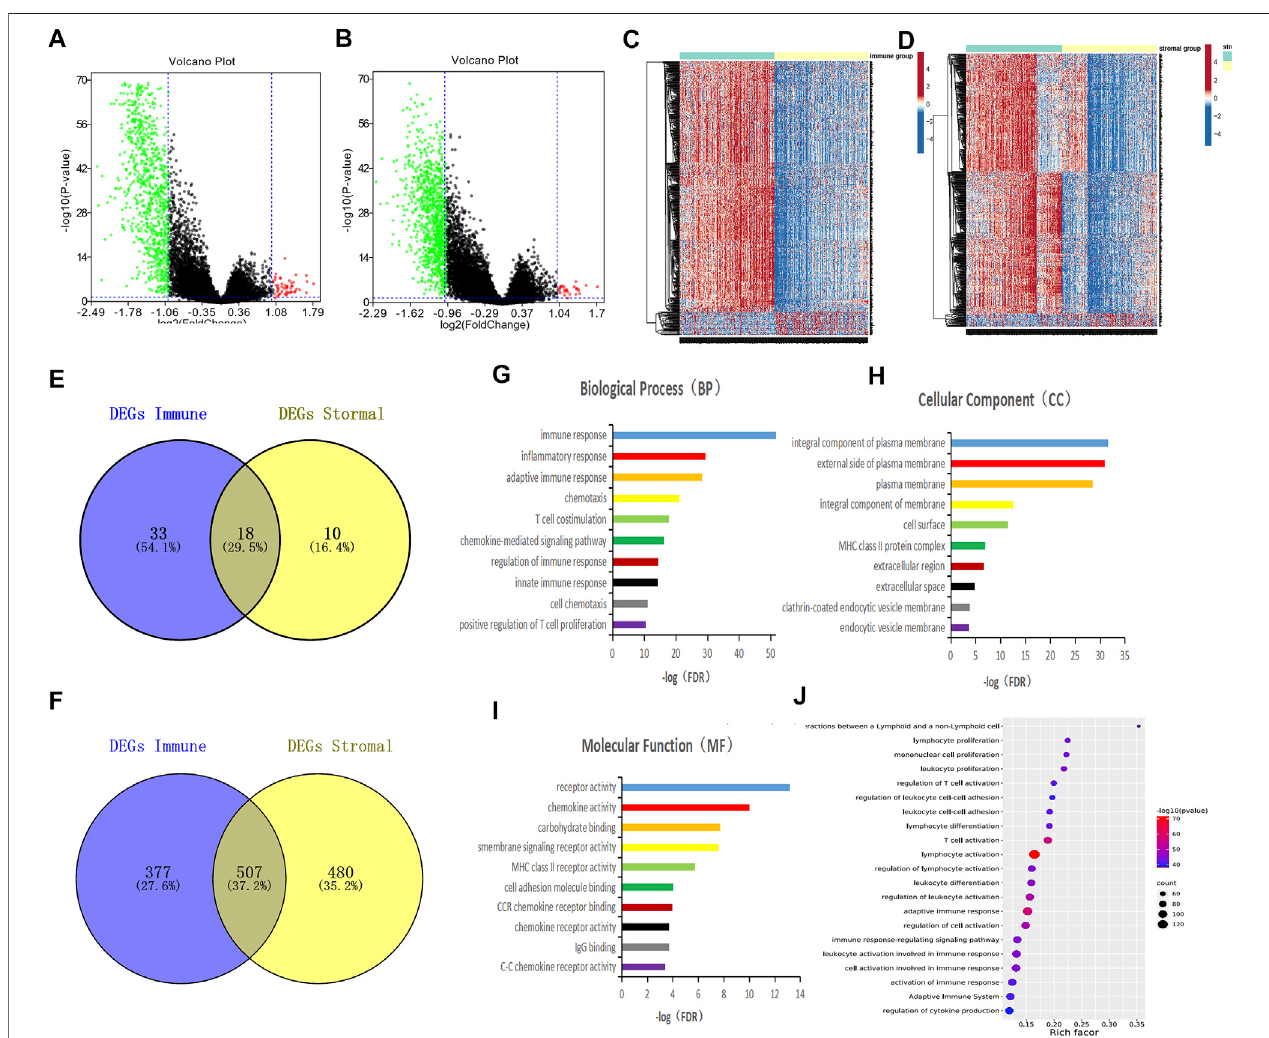
FIGURE2| Screeningdifferentialgenesrelatedtotumorimmunemicroenvironmentinlungadenocarcinoma. (A,B) PatientswithLUADweregroupedaccordingto immune/stromal scores, volcano plots were drawn using Limma package of R language, |log2FC| > 1, p < 0.05. Genes with high expression are shown in red, low expressionisshowningreen,geneswiththesameexpressionlevelareinblack. (C,D) HeatmapoftheDEGsofimmune/stromalscoresoftophalf(highscore)vsbottom half(lowscore). p < 0.05,FC > 1) (E,F) Venndiagramsshowingthenumberofcommonlyupregulated (E) ordownregulated (F) DEGsinstromalandimmunescore groups. (G – I) Top 10 GO terms. False discovery rate (FDR) of GO analysis was acquired from DAVID functional annotation tool, p < 0.05. (J) Bubble plots showed the annotation of the DEGs KEGG pathway, p <